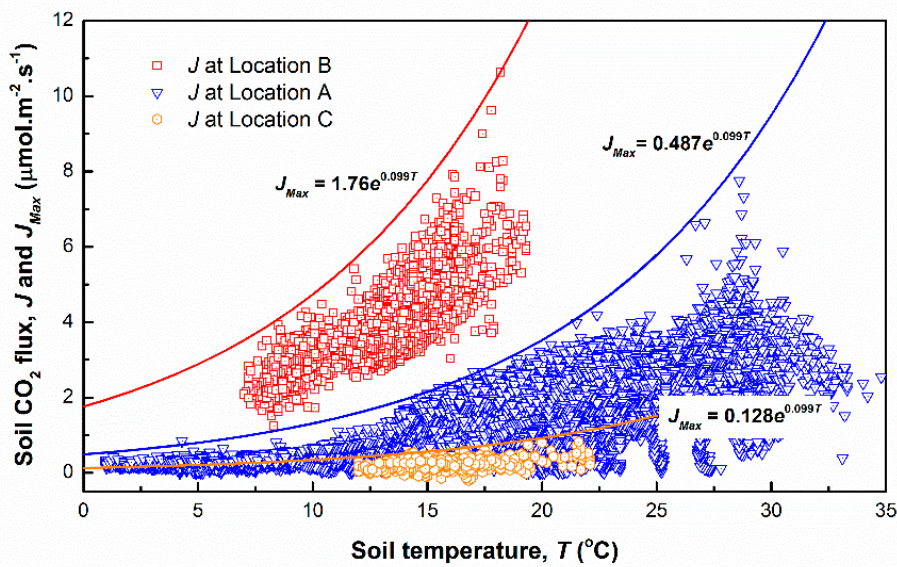
Figure 14. Comparison of the relationship between CO 2 flux from soil ( J ) and soil temperature ( T ) at Location A (Dec 1, 2016 to Nov 26, 2017), B (Nov 1, to Dec 9, 2018), and C (Oct 25, to Nov, 2018). Based on the results from Figure 14, the following three equations were obtained: